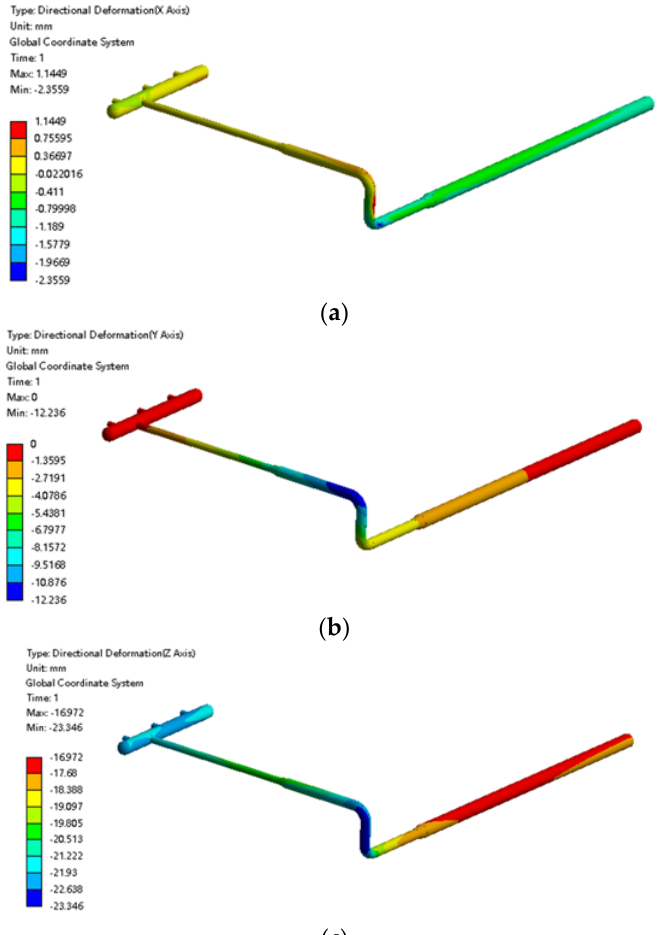
Figure 21. Cloud diagram of pipeline displacement at − 1 ◦ C: ( a ) cloud diagram of pipeline dis- placement at the x direction; ( b ) cloud diagram of pipeline displacement at the y direction; ( c ) cloud diagram of pipeline displacement at the z